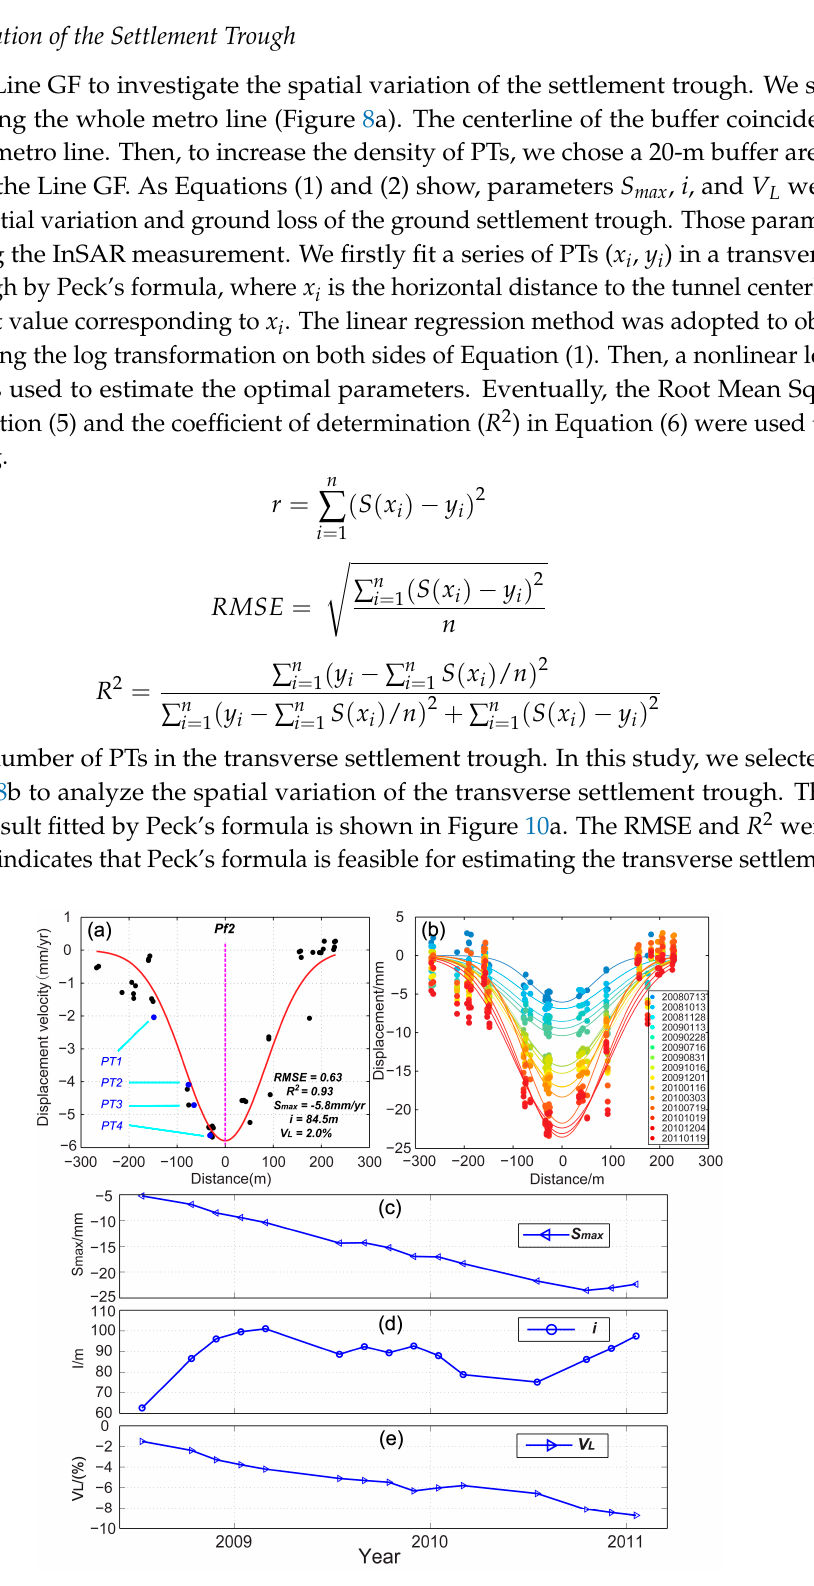
Figure 10. The Pf2 result fitted by Peck’s formula and long-term model parameters of Pf2 based on time-series IPTA. ( a ) The result fitted by the Peck’s formula; The pink dotted line denotes the curve centerline; ( b ) time-series settlement trough fitting curves; and ( c − e ) the variation of structural parameters during the study period.